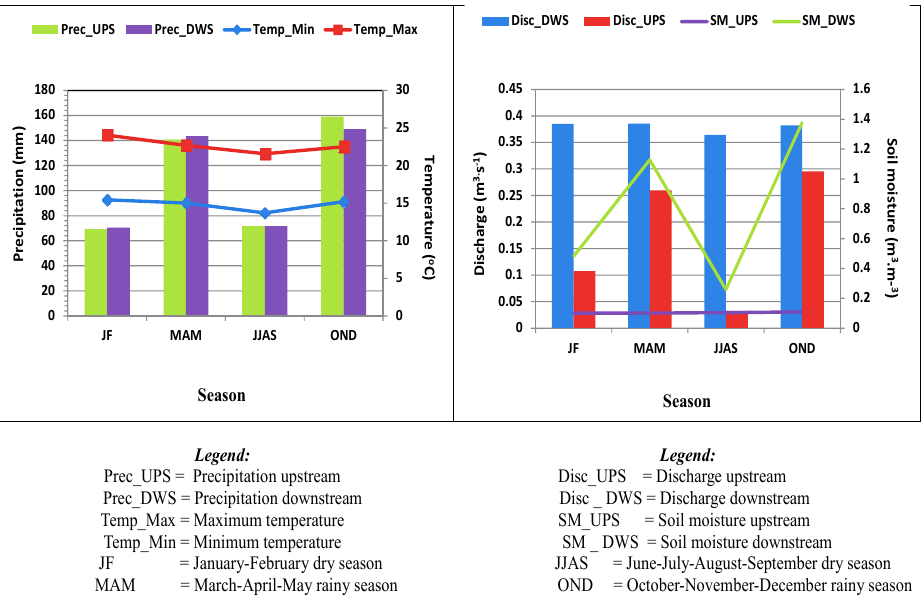
Figure 2. Seasonal hydro ‐ climatograph of Muooni catchment (1971–2010) [33].